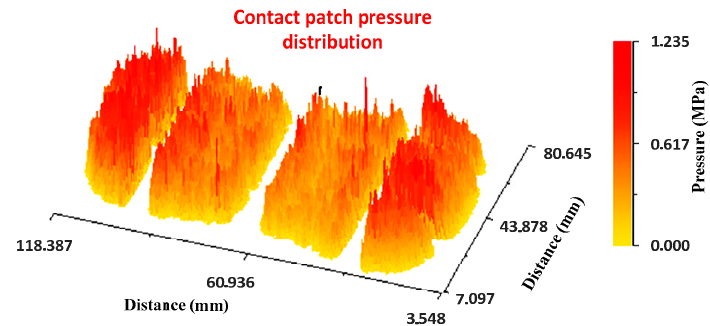
Figure 21. Contact patch pressure distribution. No defect area.